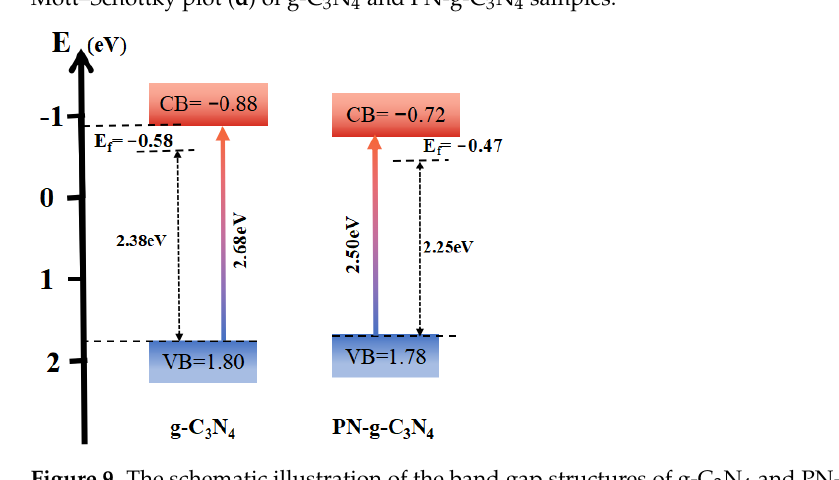
Figure 9. The schematic illustration of the band gap structures of g-C 3 N 4 and PN-g-C 3 N 4 sam- ples.